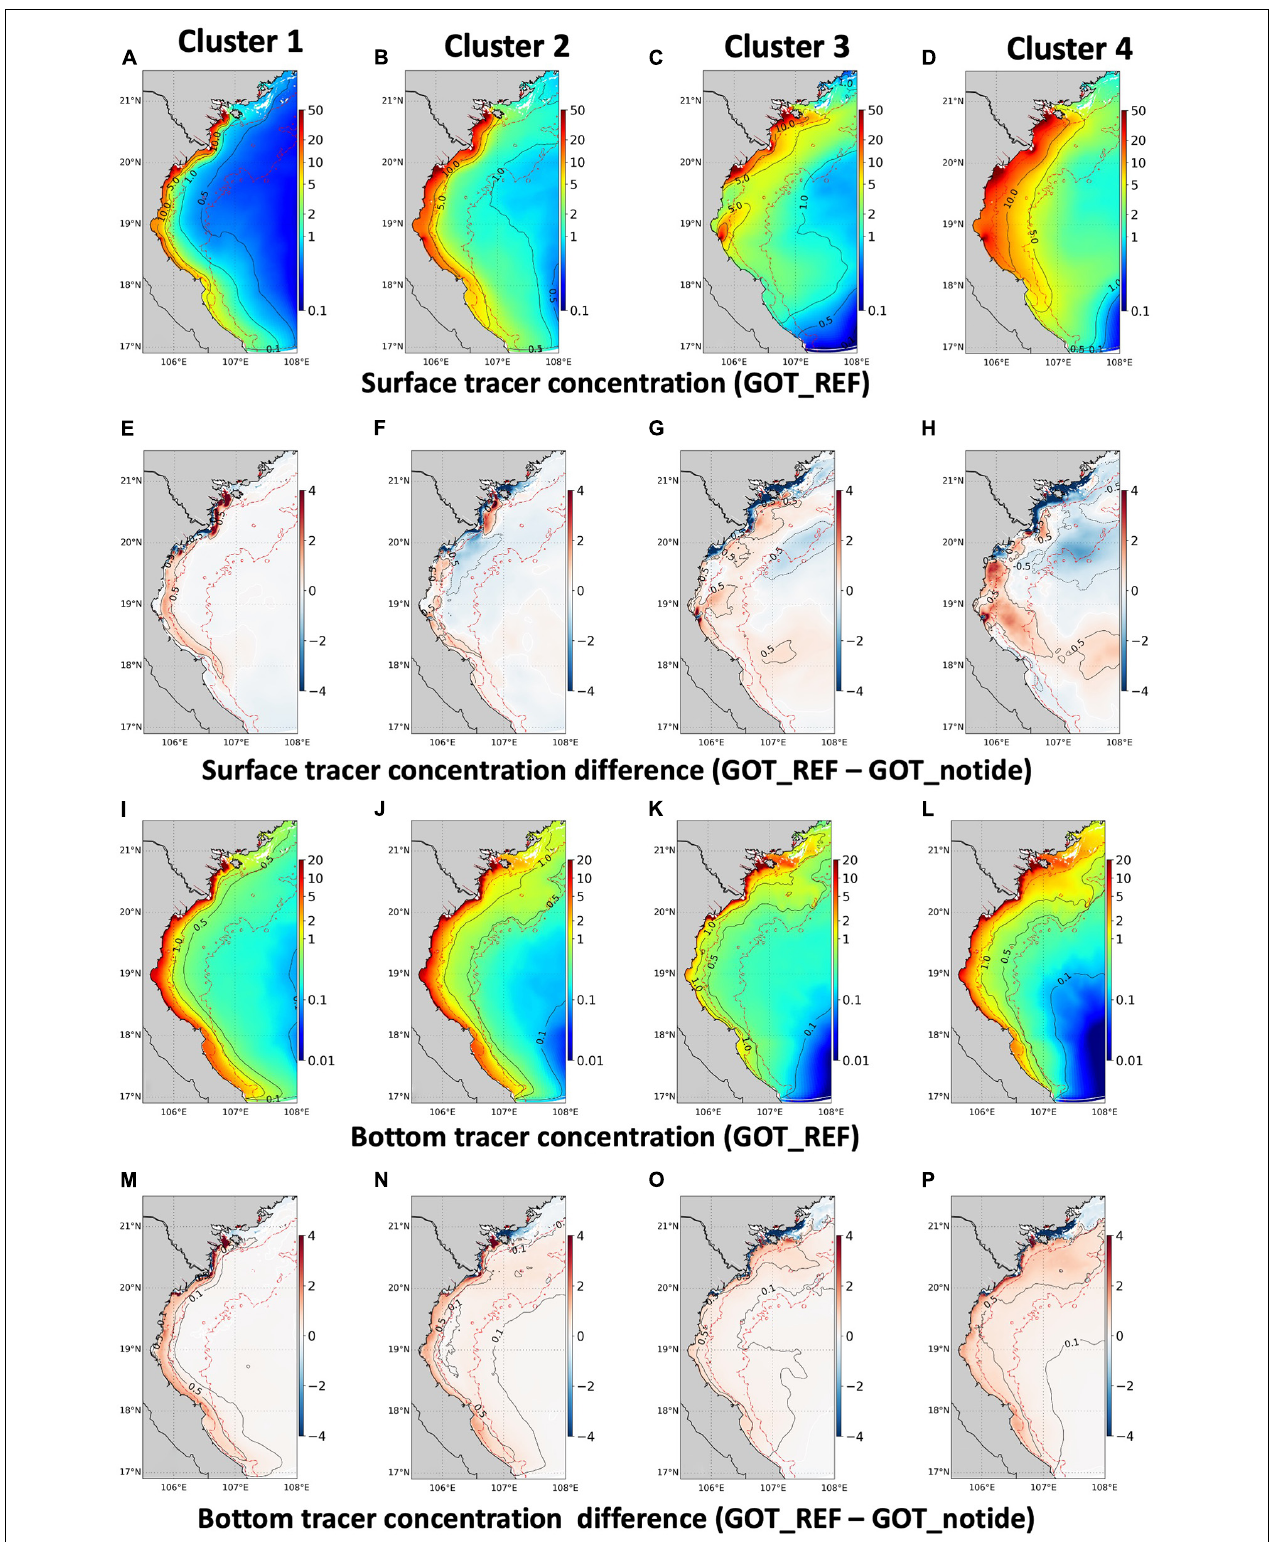
FIGURE 13 | (A–D) Maps of mean surface tracer concentration correspond for 4 clusters. (E–H) Difference of surface tracer concentration between GOT_REF and GOT_NOTIDE correspond for 4 clusters. (I–L) Same as (A–D) but at the bottom. (M–P) Same as (E–H) but at the bottom.